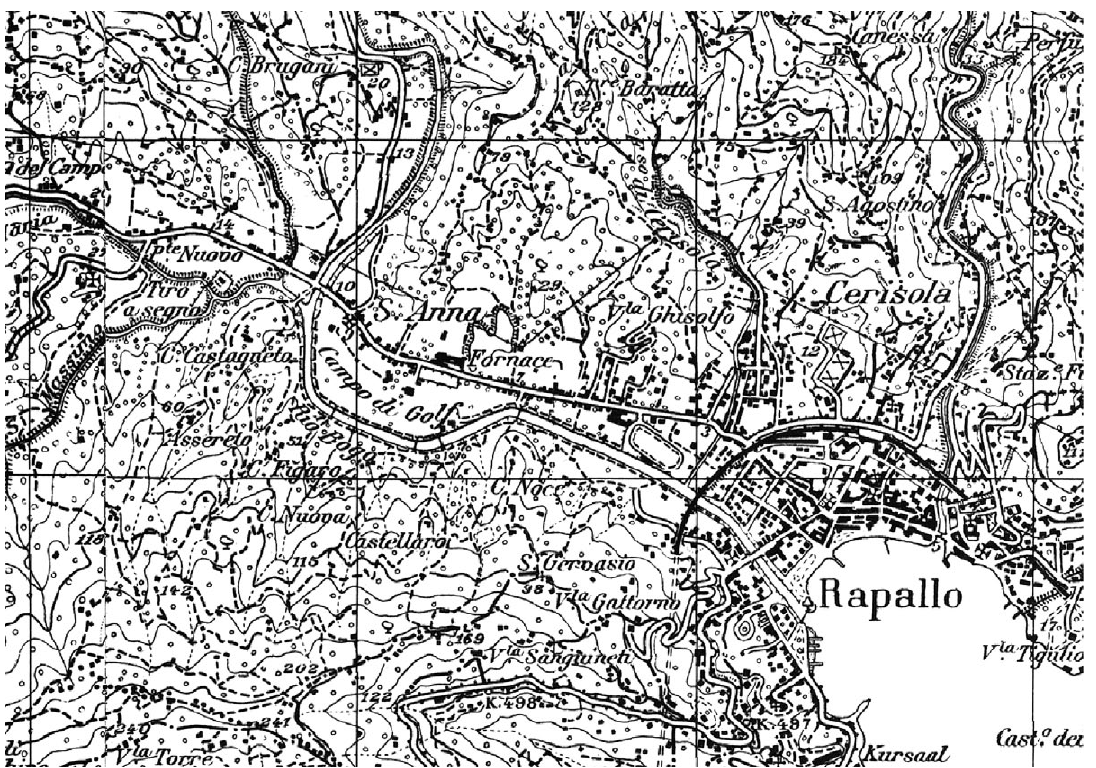
Fig. 8. Rapallo flood plain in the 1936s (after 1.25.000 scale map, IGMI Archives).